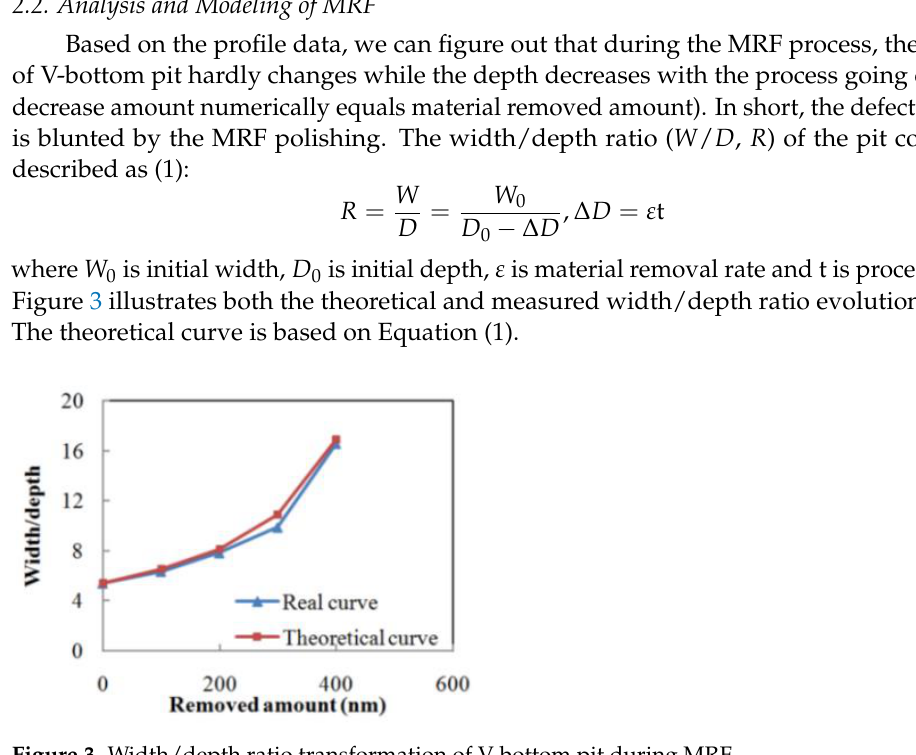
Figure 3. Width/depth ratio transformation of V-bottom pit during MRF.